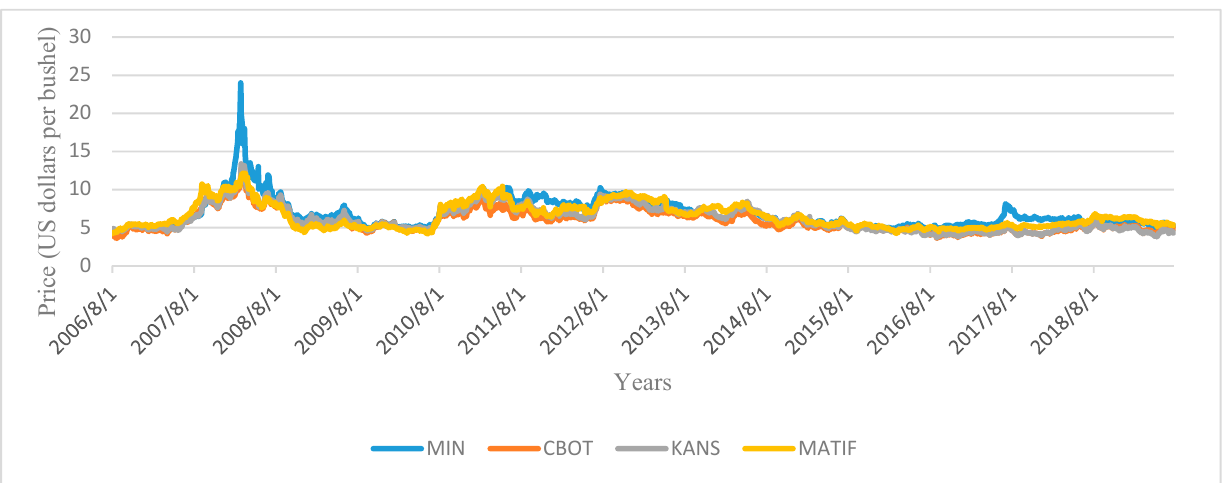
Figure 1. Daily settlement price series for wheat future contracts (the Chicago Board of Trade (CBOT), the Marché à Terme International de France (MATIF), Kansas, and Minneapolis) expressed in US Dollars/bushel. Source AHDB, 2019. Table 2. Summary statistics first differenced logged price discovery for CBOT, MATIF, Kansas, and